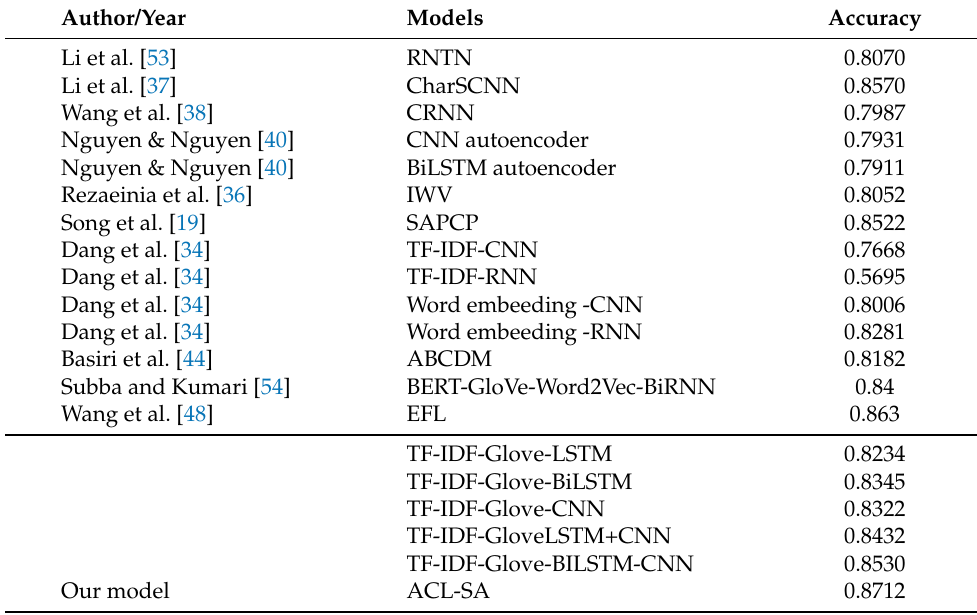
Table 3. Sentiment140 dataset and the baseline models’ accuracy